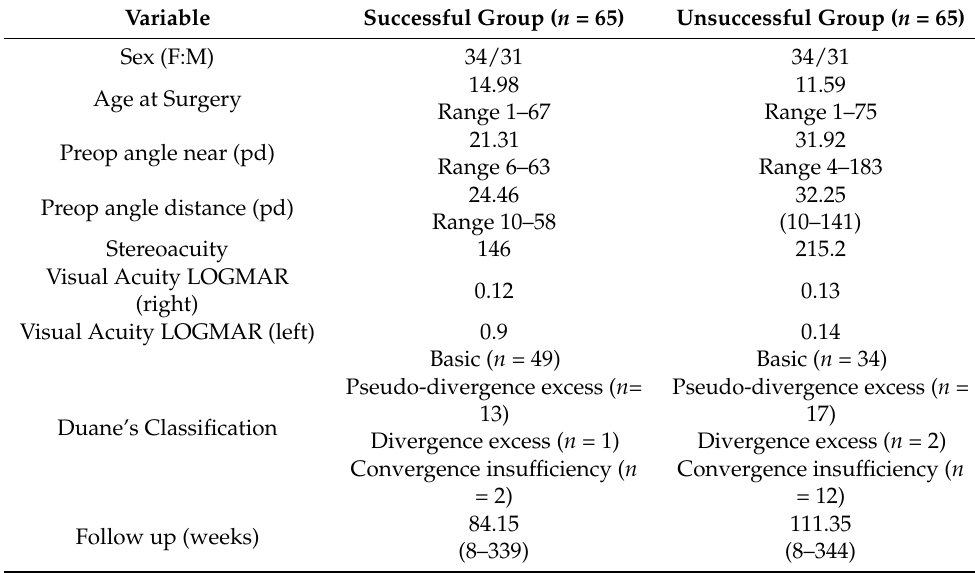
Table 3. Mean values describing patient demographics and clinical presentation from successful and unsuccessful groups. (pd= prism